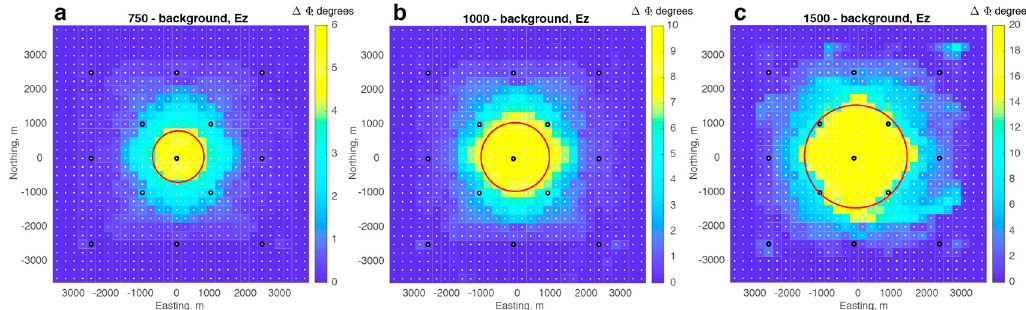
Figure 2. Radial mode 0.25 Hz vertical electric field phase change between background and reservoir, projected onto transmitter–receiver midpoints (white dots) and averaged over all data. ( a – c ) Target reservoirs with radii of 750, 1000, and 1500 m, respectively, outlined in red. Transmitter locations shown as black circles. Note the change in phase scale between plots.